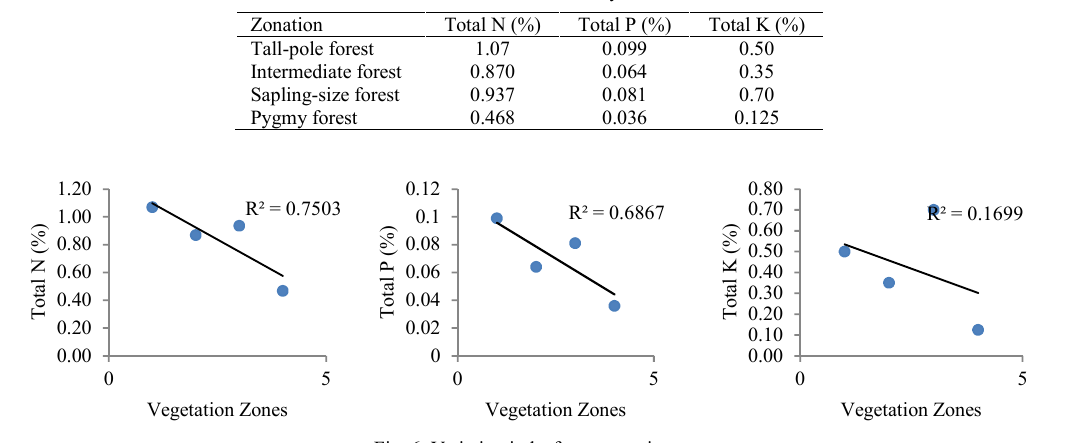
Table 3: Leaf tissue analyses